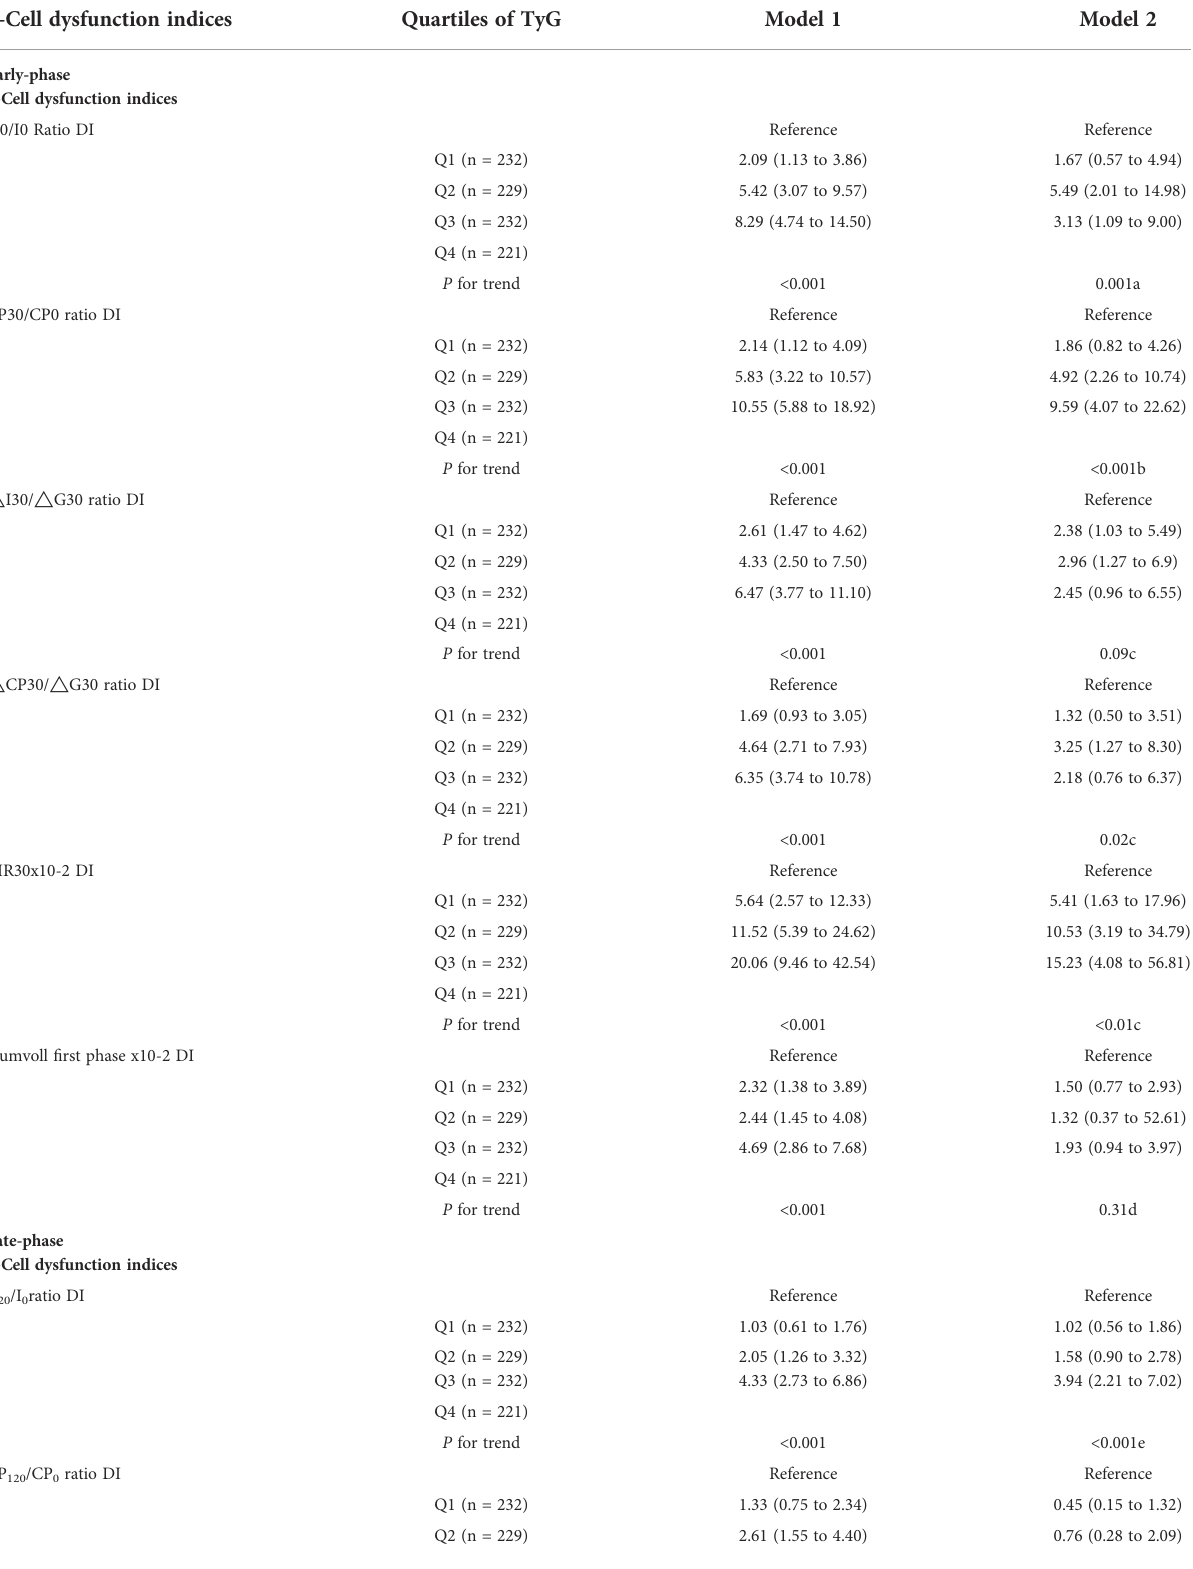
TABLE 3 Odds ratios for the risk of b cell dysfunction according to TyG